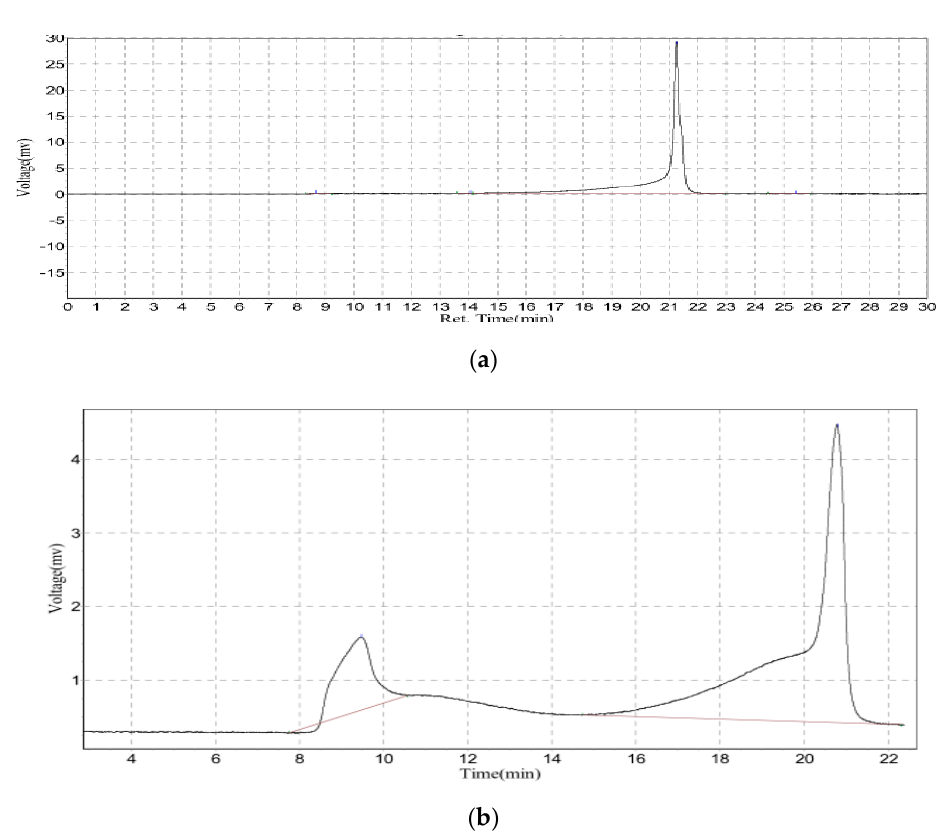
Figure 13. Extended GFC analysis: ( a ) GQDs; and ( b ) GQDs with lecithin liposome-encapsulated TiO 2 nanoparticles (1.0 mg/mL), using λ ex,max = 350 nm and λ em,max = 395 nm for FD.